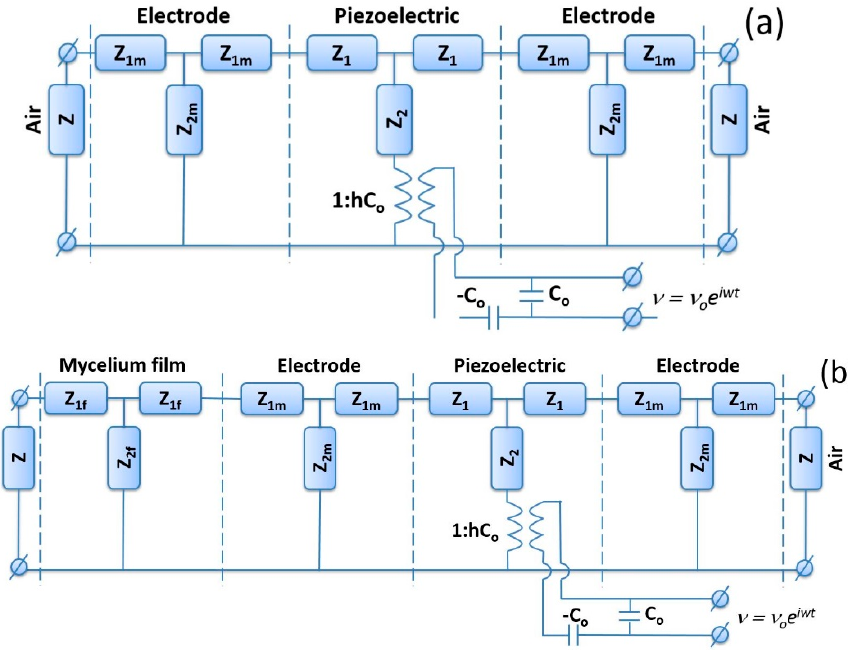
Figure 5. Mason’s equivalent circuits for the resonator with electrodes ( a ) without and ( b ) with the mycelium film under study.